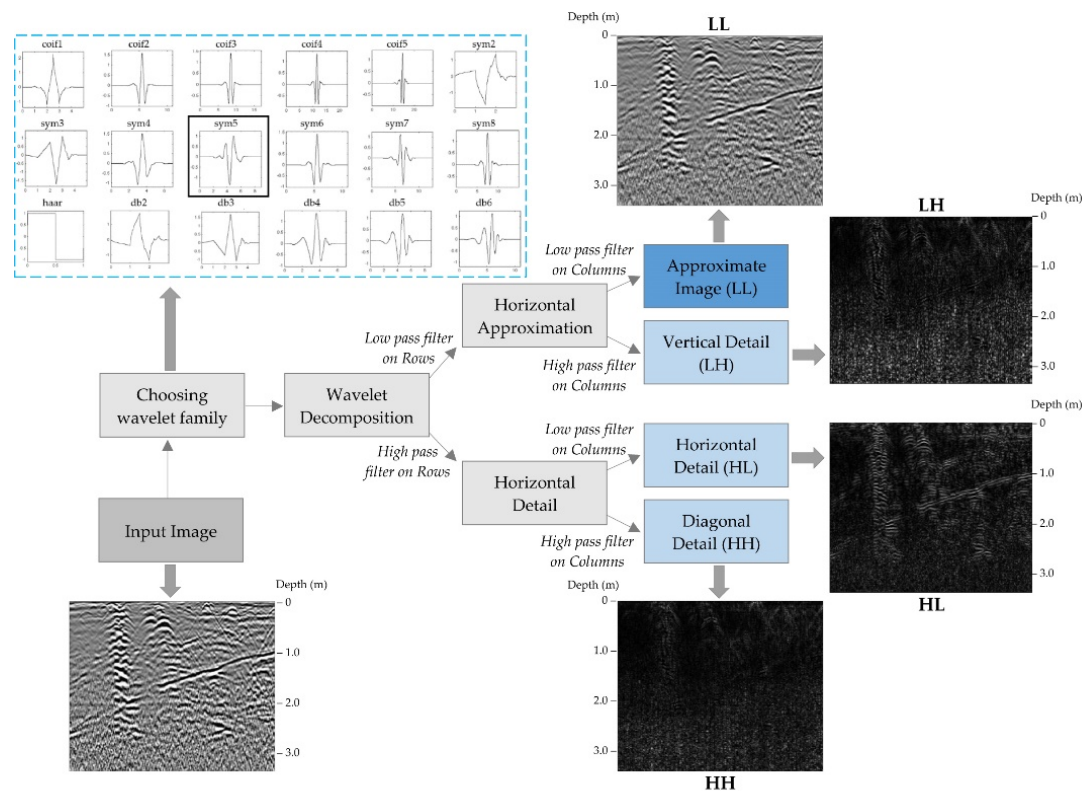
Figure 8. Diagram illustrating the decomposition of a sample radargram on level 1.